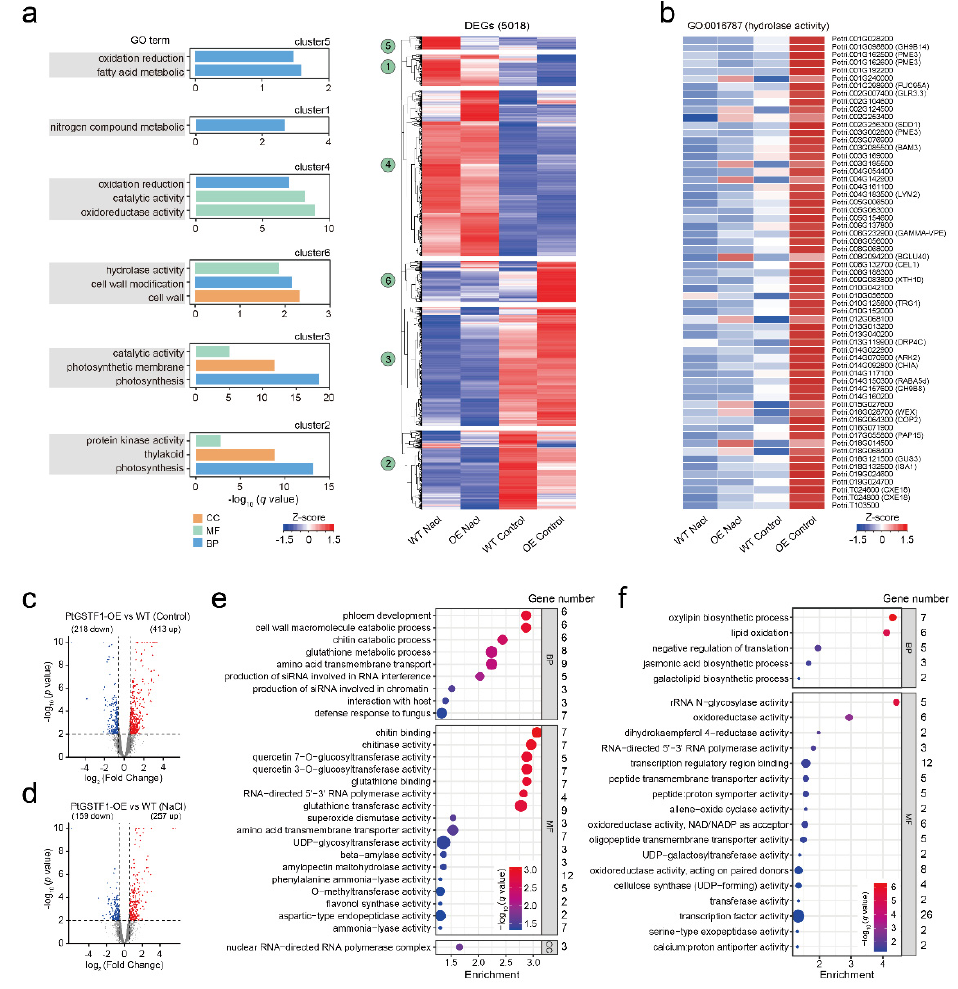
Figure 7. Transcriptomic profiling analysis. Four − week − old wild type (WT) and PtGSTF1 transgenic line OE5 plants grown in a greenhouse were treated with 0 (control) or 150 mM NaCl for 48 h. The 3rd to 5th full expanded leaves from the apex were taken for RNA-seq analysis. ( a ) Hierarchical clustering and heatmap of 5018 differentially expressed genes (DEGs) in transgenic line OE5 compared to the WT plants treated with 0 and 150mM NaCl. Full results of GO enrichment analysis of heatmap DEG clusters are shown in Table S2. ( b ) Expression of genes related to hydrolase and cell wall modification in cluster 6. The Z-score scale represents mean-subtracted regularized log-transformed FPKM. ( c , d ) Volcano plots showing the number of DEGs under control ( c ) and salt ( d ) stress conditions. DEGs were identified using p -value < 0.01 and absolute fold change >1.5 as criteria. ( e , f ) GO annotation of DEGs between WT and transgenic line OE5 plants under control I and salt ( f ) stress conditions.